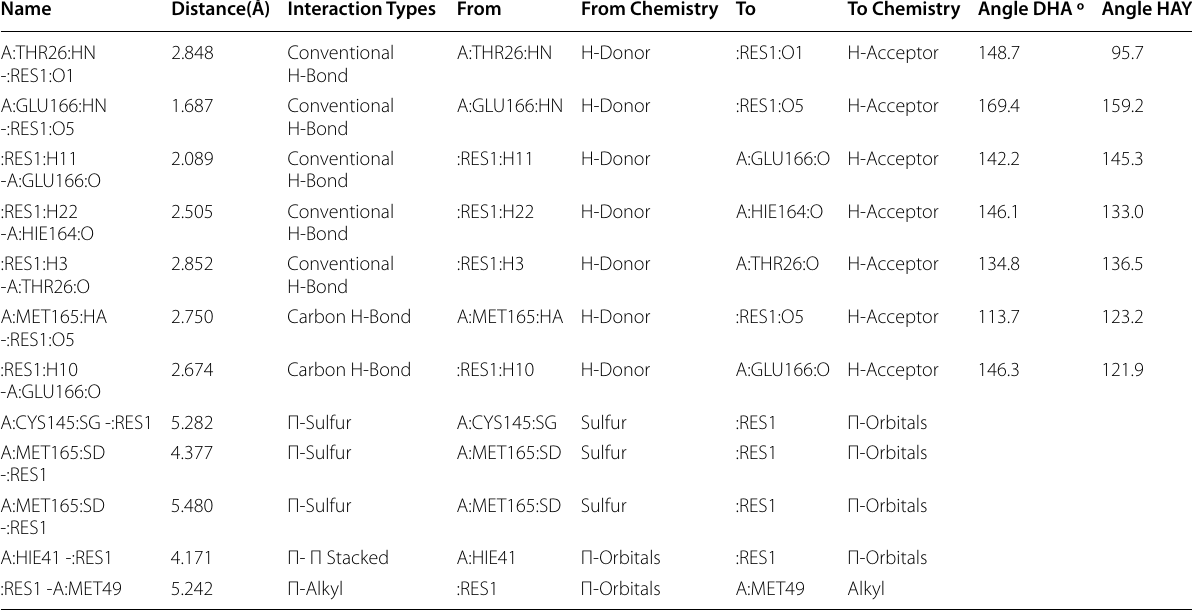
Table 5 Interaction types with surrounding amino acids of SARS CoV 2 Main Protease (PDB ID: 6XBH) with inhibitor Index number 741